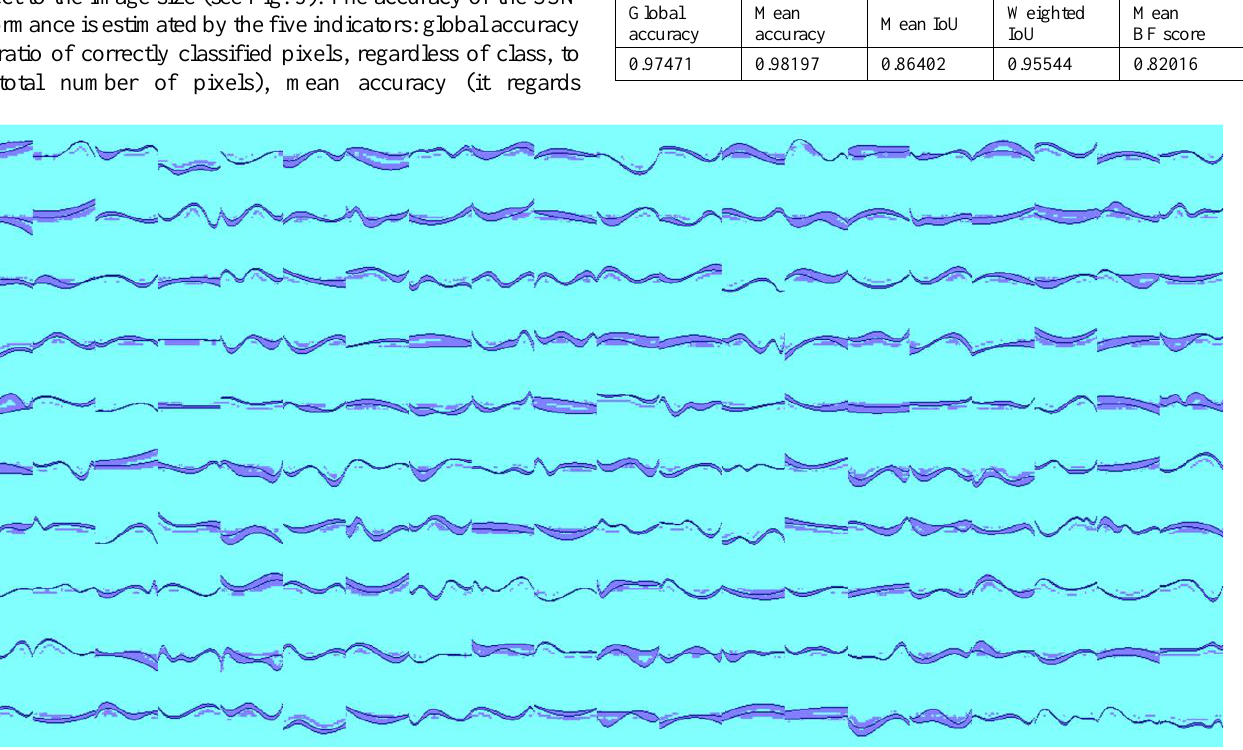
Fig. 6. The stack of 200 test images and the fused overlay image as a result of the direct SIS by the SSN trained for 33 epochs by Fig. 4 without a DropOut layer. The training is stopped due to the empty image segmentation. The global and mean accuracies here are not low at all but the mean IoU and mean BF score are really low (Table I). The weighted IoU is not low but the low mean IoU depreciates it anyway. The SSN “sees” thicker regions poorly leaving erroneously segmented pixels on outside of the regions and not segmenting their interiors entirely. Therefore, this segmentation result is too “dirty” and cannot be accepted. When a DropOut layer is turned on, the SSN with the single DeConvL is trained a lit bit slower per epoch. The entire training process in epochs is slightly longer (now, it is 36 P ERFORMANCE OF THE SSN T RAINED FOR 36 E POCHS BY F IG . epochs). The SSN has better indicators of the performance (see Table II) but the mean BF score is still unsatisfactory. The segmentation result visualized in Fig. 7 still has “dirty”